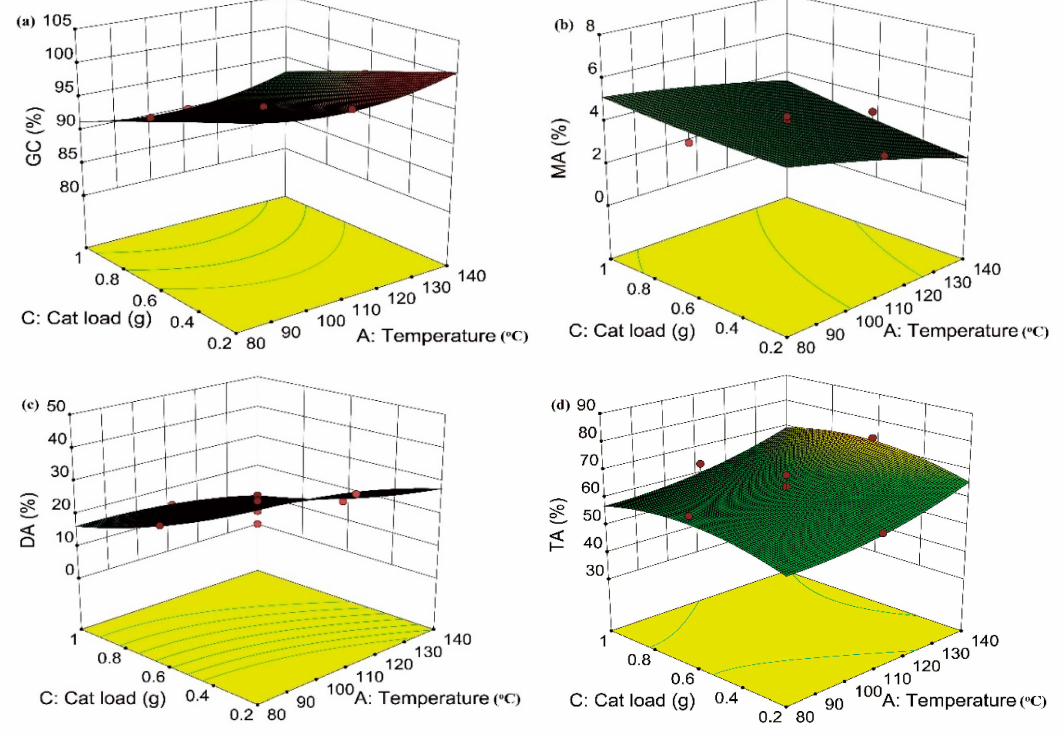
Figure 12. Surface response plots for ( a ) GC and selectivity to ( b ) MA, ( c ) DA, ( d ) TA as a function of the catalyst load, and temperature at a constant G / AA mole ratio (1:9) and reaction time (3